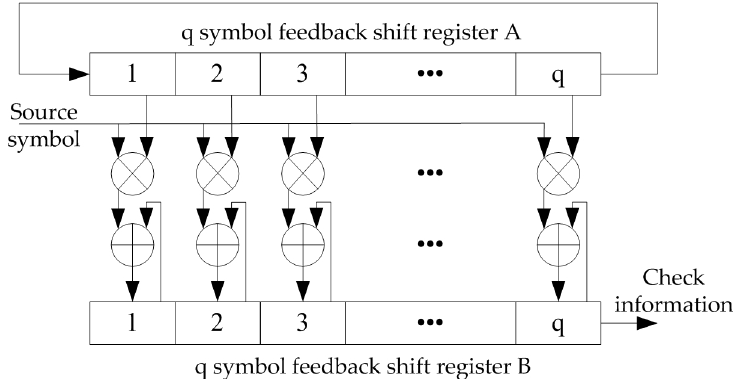
Figure 9. Serial shift register accumulator unit.